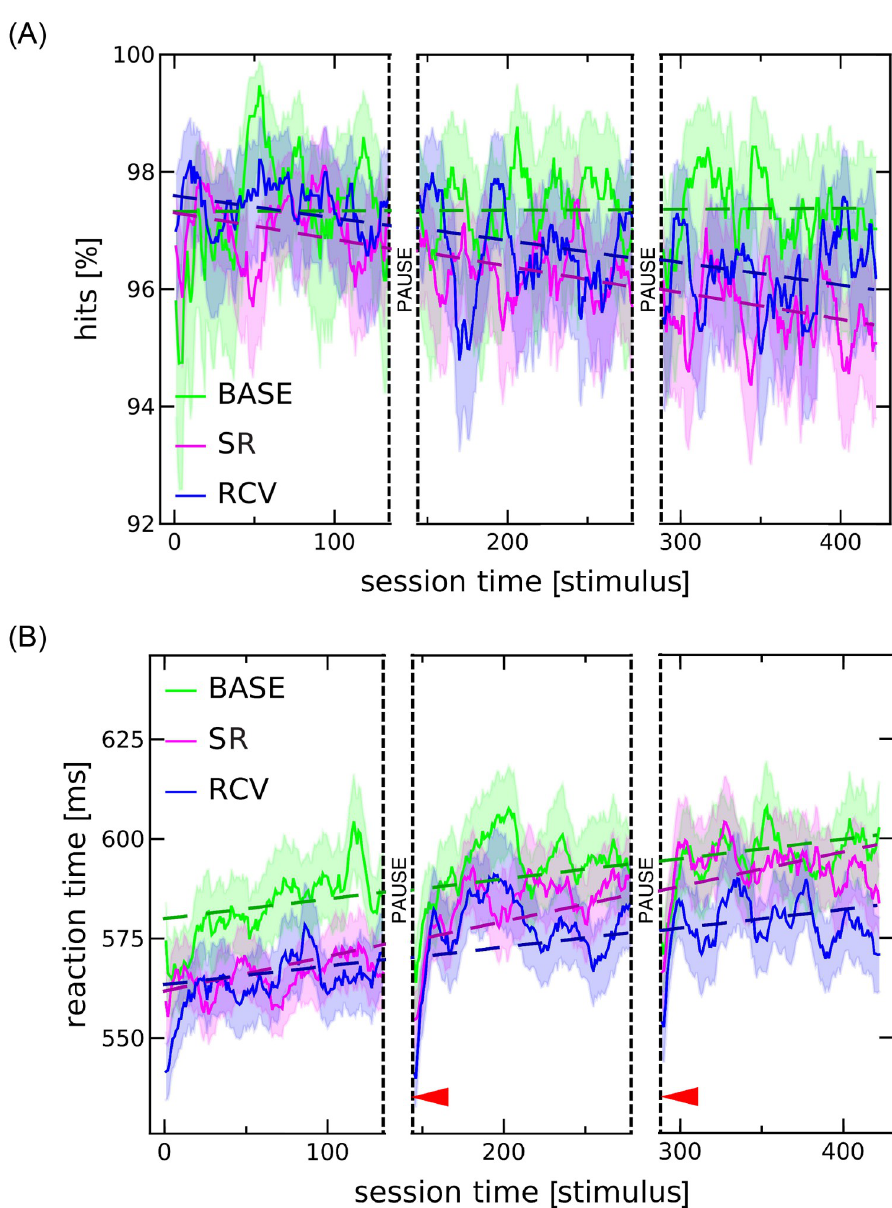
Fig 3. Accuracy (top) and reaction times (bottom) as functions of time spent on performing the task (measured by the number of stimuli presented). Vertical dashed lines indicate pauses between blocks of the Stroop task. The curves represent means over subjects and days within a given condition. and the shaded regions 95% confidence intervals; The straight lines are linear fits; the RT slope is significantly higher in SR. Red triangles point to RTs dropping just after the pause, which happens in all